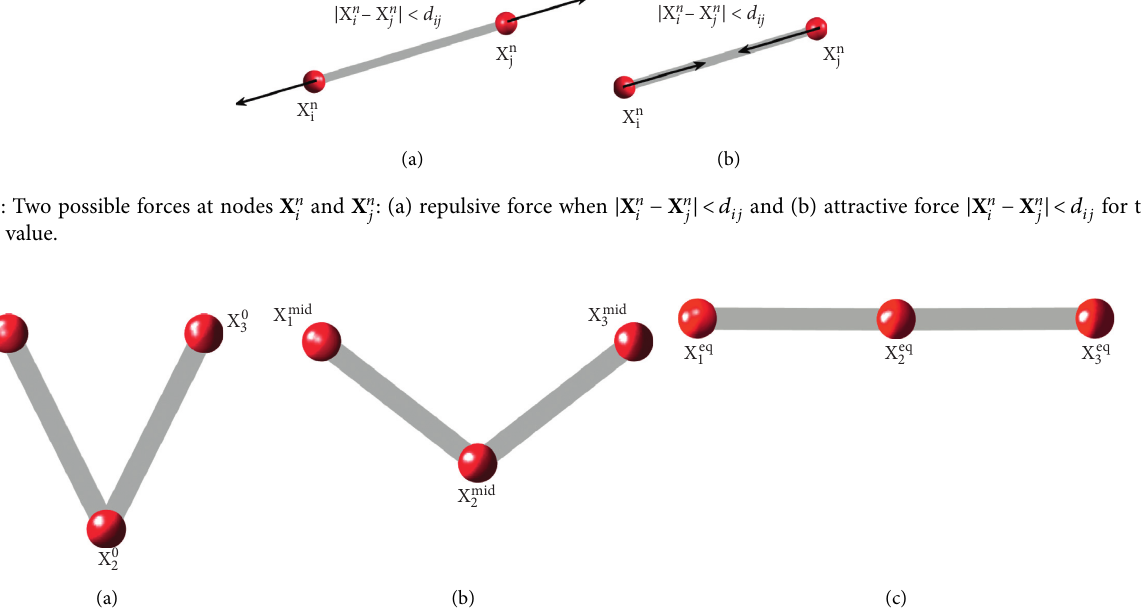
ij using the normalized weighting value